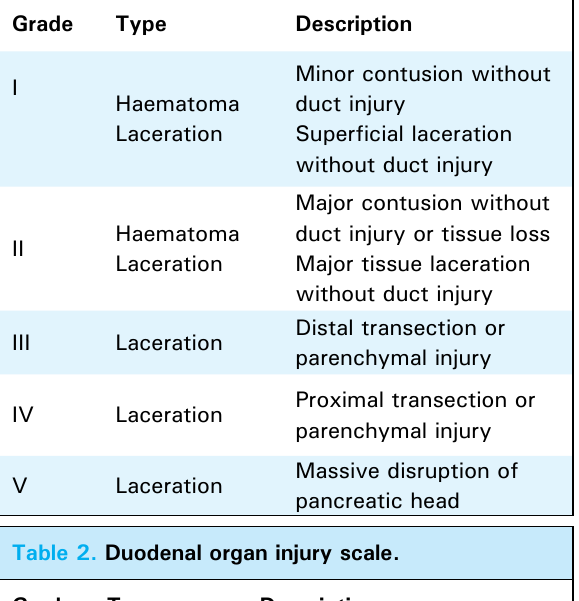
table 1. Pancreas organ injury scale.